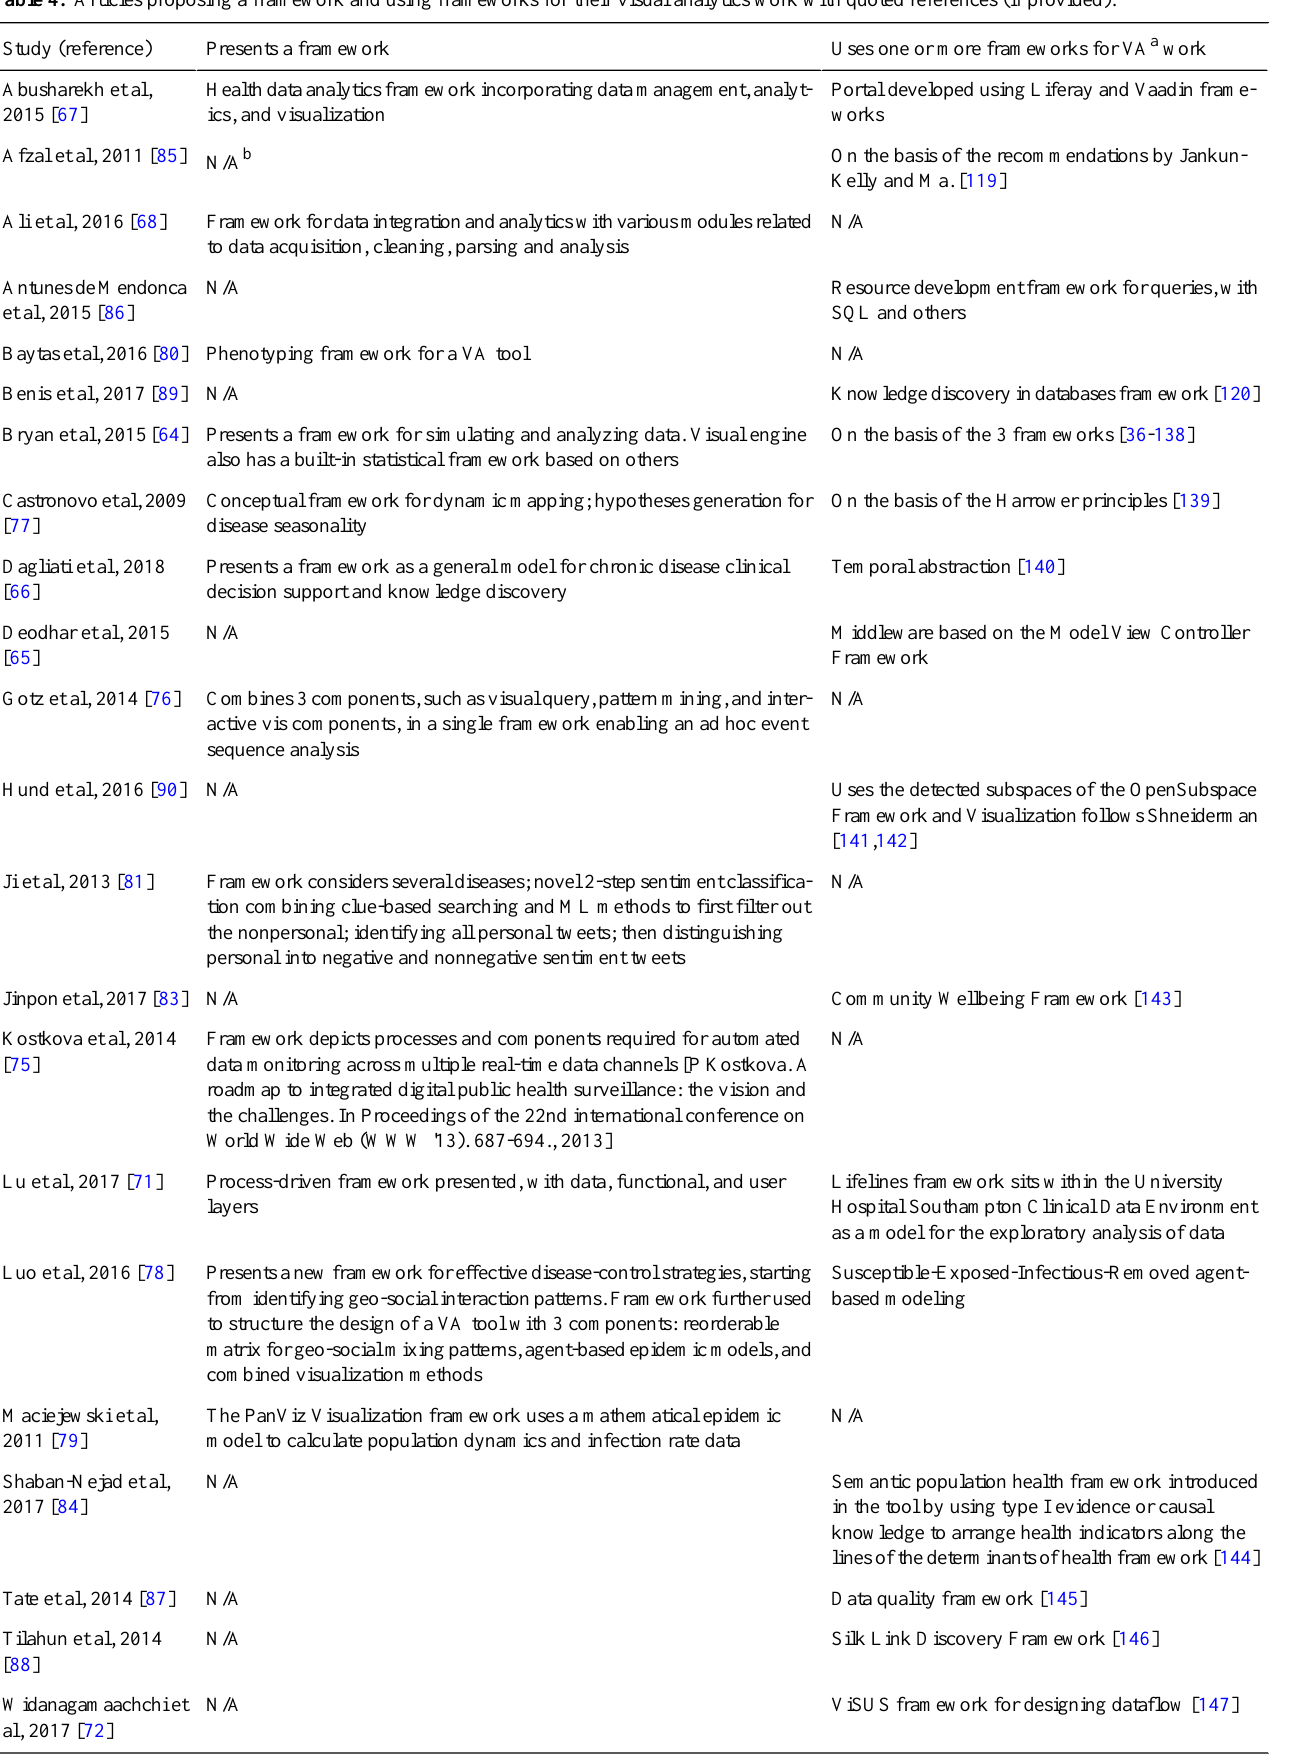
Table 4. Articles proposing a framework and using frameworks for their visual analytics work with quoted references (if provided). visualizationAbusharekh et al, 2015 [67]